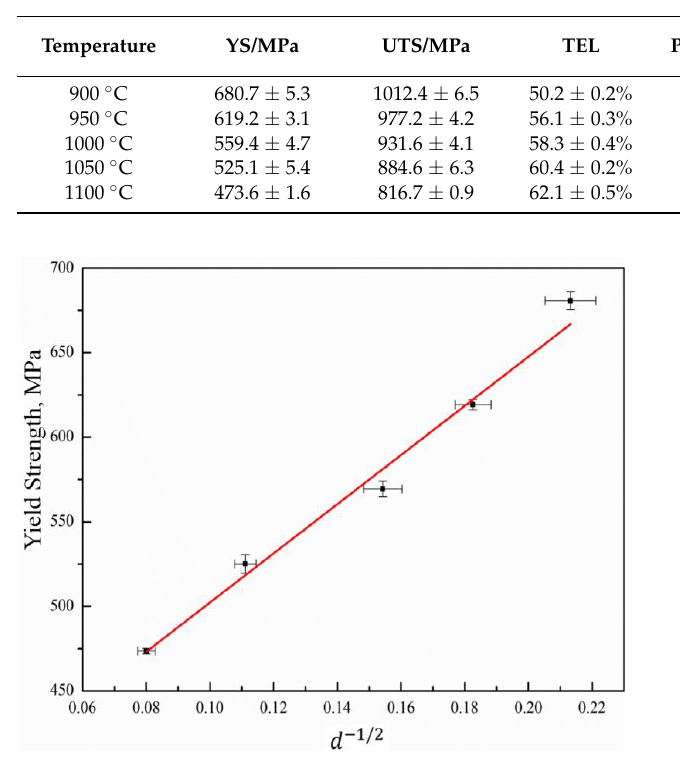
Figure 4. Engineering stress–strain curves of experimental steel under different annealing conditions. Table 2. Mechanical properties of experimental steel under different annealing conditions.